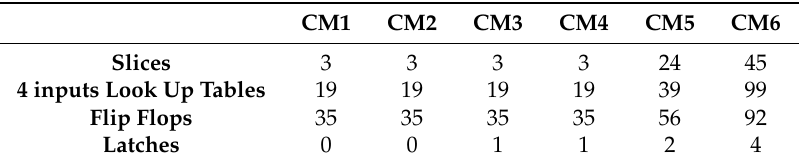
Table 2. Hardware resources consumed by the capture modules.